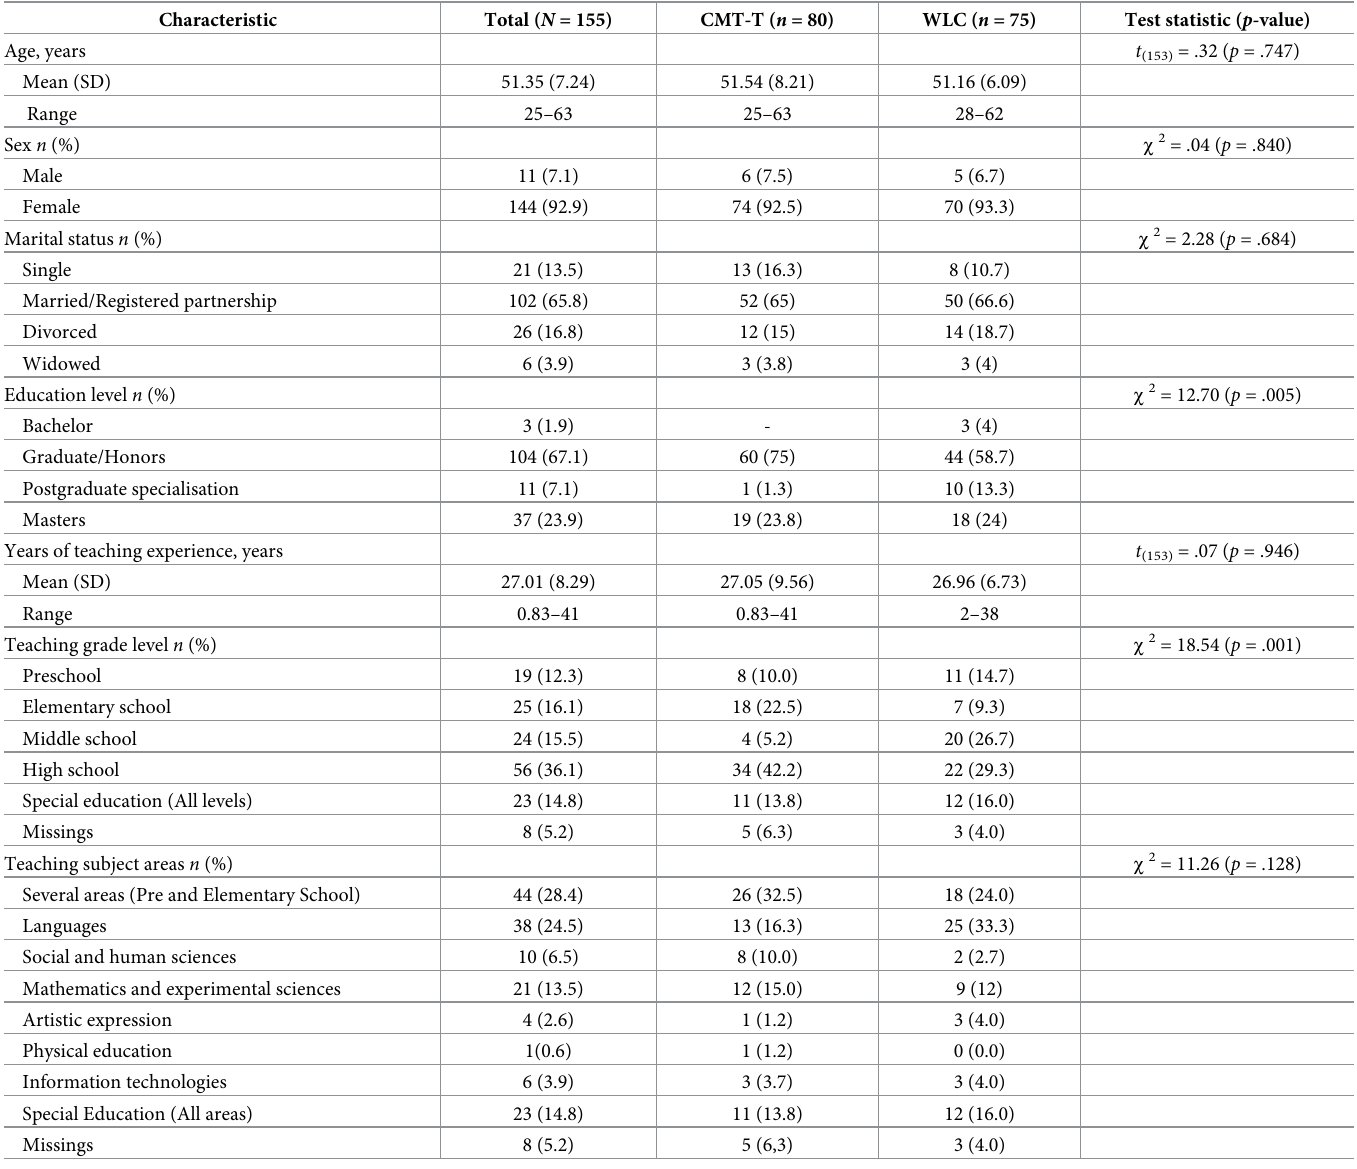
Table 1. Baseline characteristics of the participants ( N =